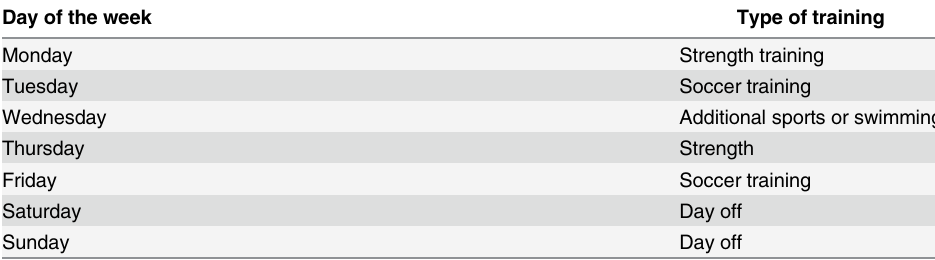
Table 3. General activity content of weekly